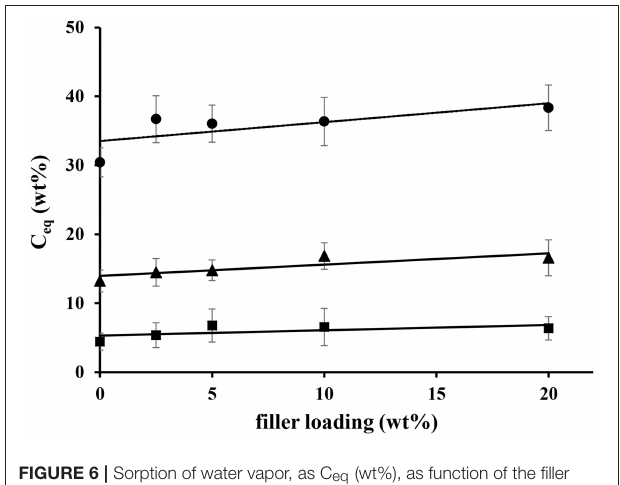
FIGURE 6 | Sorption of water vapor, as C eq (wt%), as function of the filler loading at relative moistures 23% ( ), 55% ( ), and 80% ( ). TABLE 3 | C eq (wt%) of water vapor sorbed at different moisture for unfilled TPs film and composites. Filler loading (wt%)